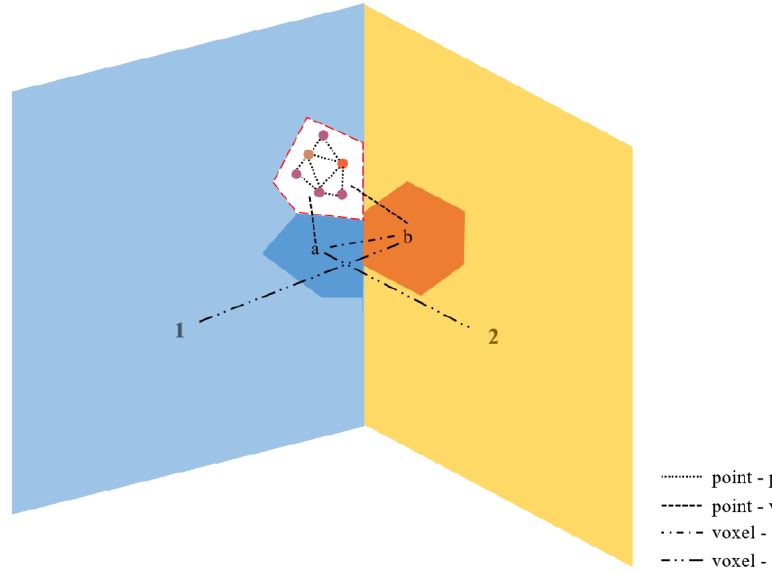
Figure 7. Multi-level relationships between different primitive types where the numbers 1 and 2 represent two planes, the letters a and b represent the corresponding voxels, and the dots represent the points in a voxel.